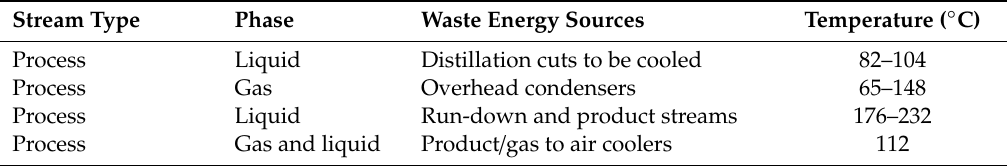
Table 1. Characterization of the low-grade heat streams in oil refineries